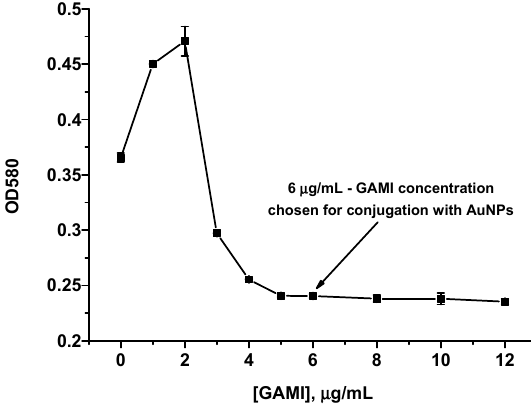
Figure 2. Flocculation curve obtained for GAMI.